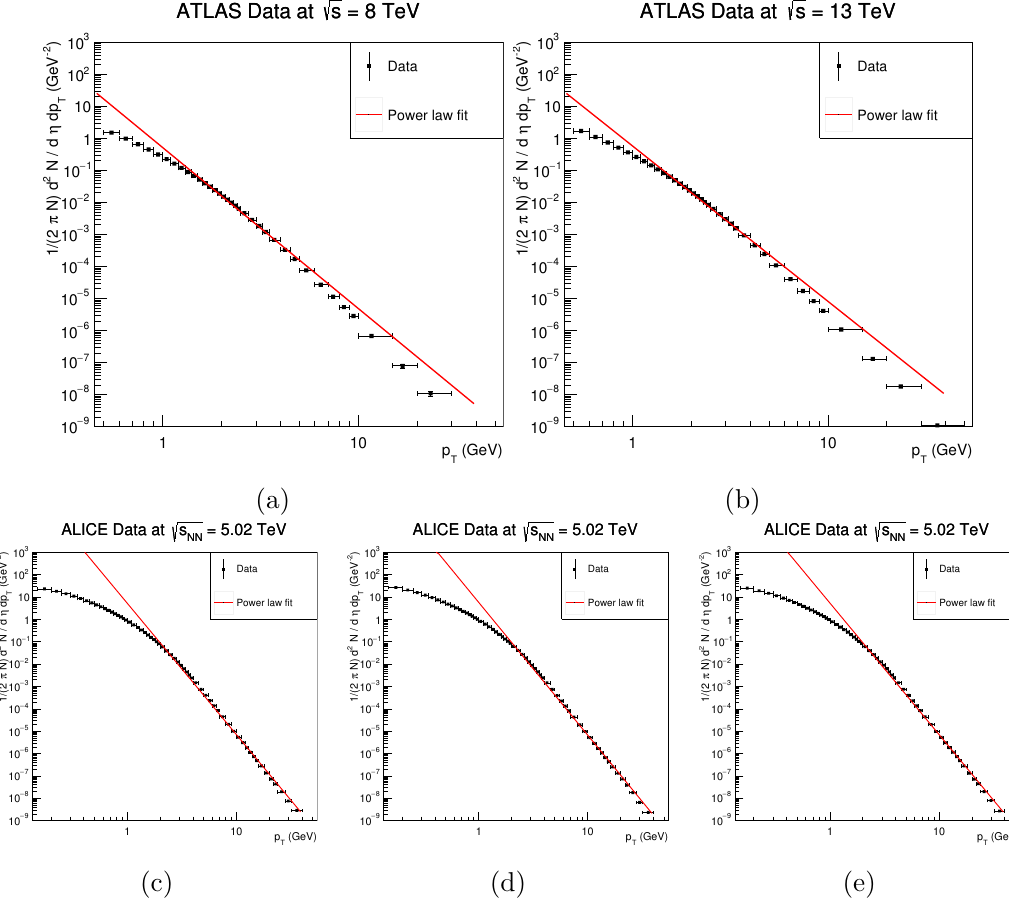
Figure 4. Pure power-law ( A=p B ) (cid:12)ts for the ATLAS p s = 8 TeV (a) and p s = 13 TeV (b) data T sets, as well as the ALICE p s = 5 : 02 TeV data set at rapidity bins of (d), and 0 : 8 < (cid:17) < 0 : 3 (e) (cid:0) (cid:0)